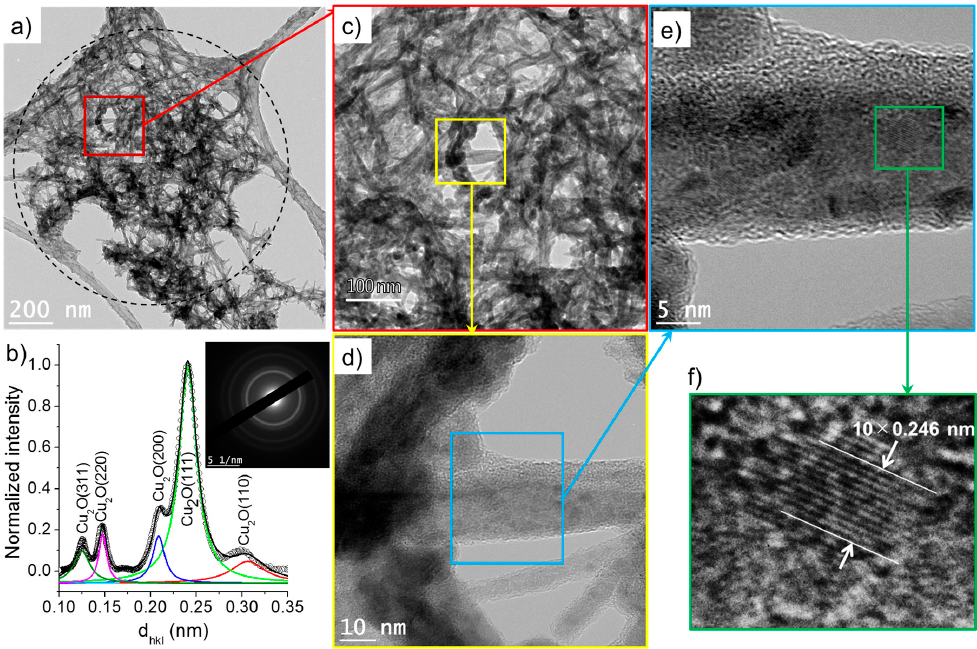
Figure 10. ( a ) TEM images of nanowires synthesized in the case 2 ( σ 0 = 8 µS/cm) and ( b ) the corresponding SAED pattern (performed on the encircled zone in ( a )) radially integrated spectrum. ( c – f ) show the HR-TEM images of nanowires.